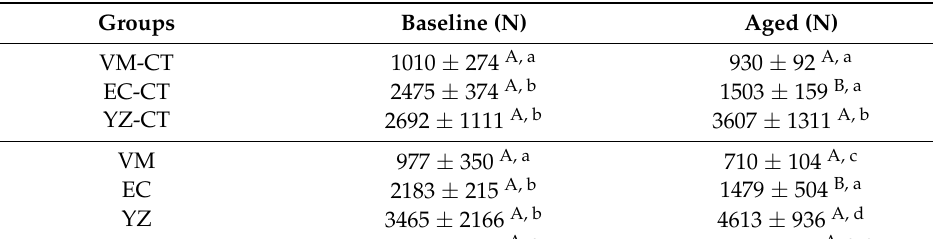
Table 4. Fracture load means and standard deviations. Statistically significant differences between groups determined with the Fisher-LSD post-hoc test are indicated with varying superscript letters ( p > 0.05) (upper case horizontal, lower case vertical).